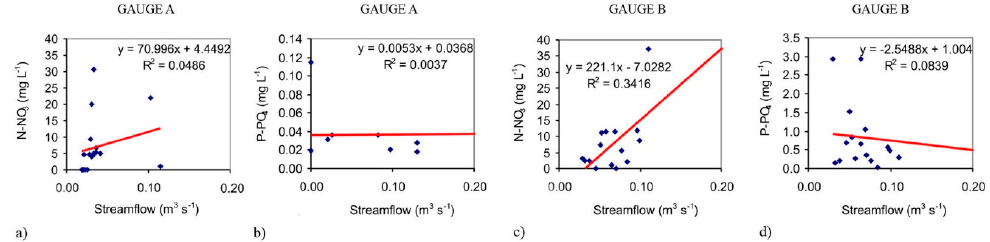
Figure 5. Measured N-NO 3 ( a , c ) and P-PO 4 ( b , d ) concentrations versus measured streamflow at gauging stations A and B.